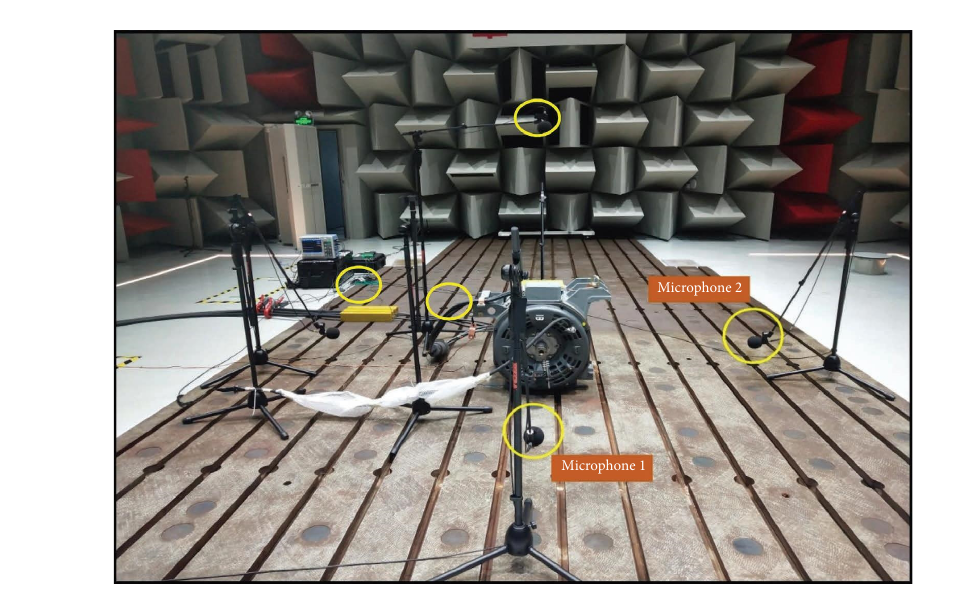
Figure 3: Test bed. Table 2: Summary of signal sampling duration.